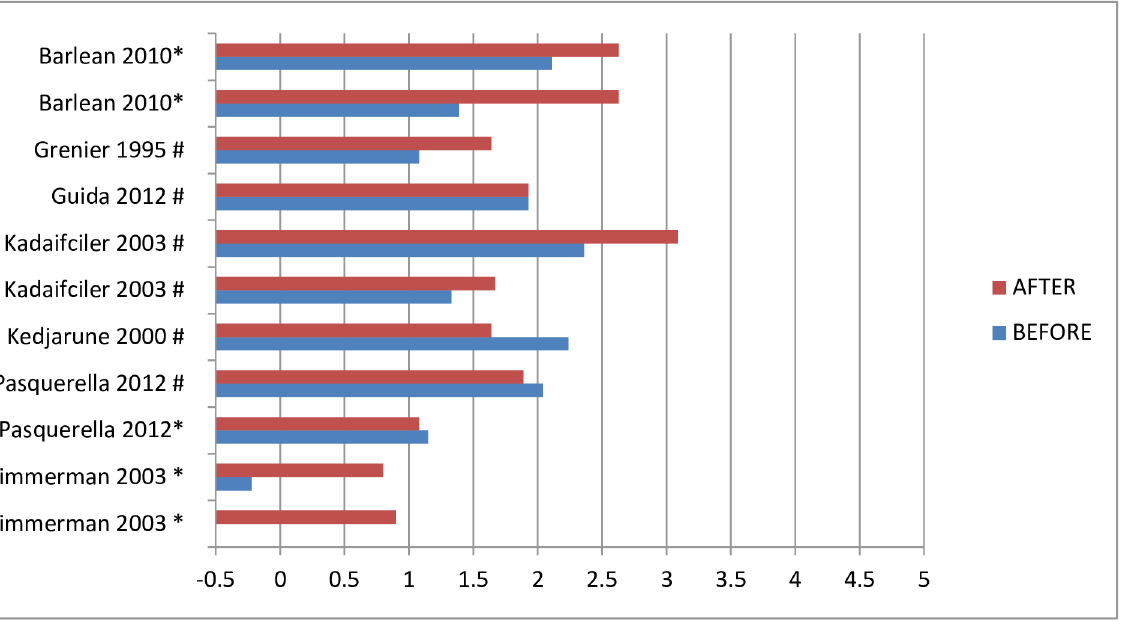
Fig 5. Bacterialor fungal loads in mean Log-10 CFU/m 3 in dental, measuredtwice. * = passive samplingmethod; # active